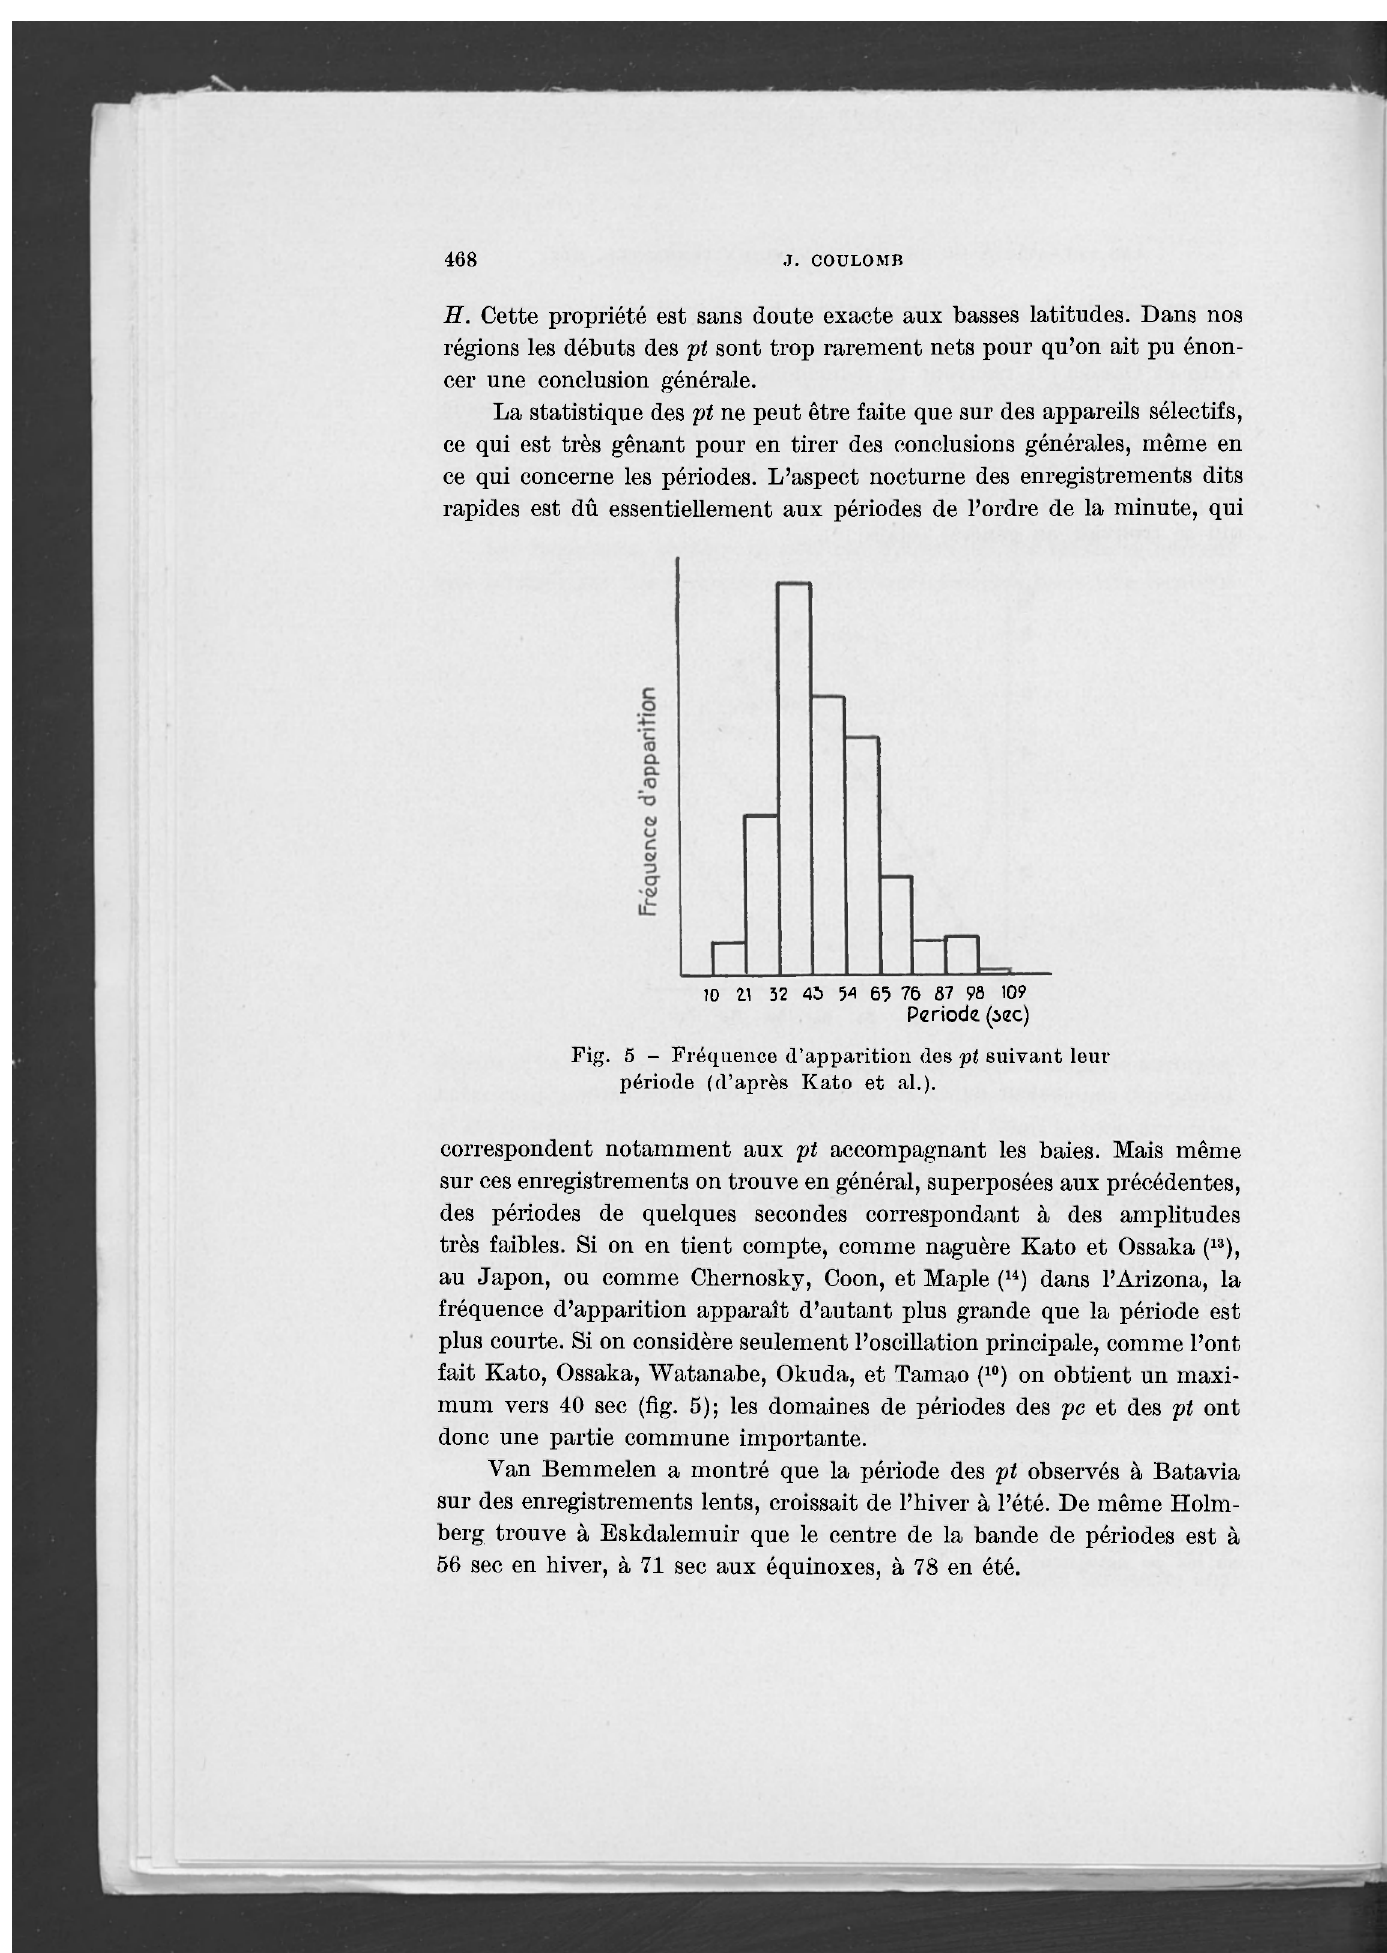
Pig. 5 - Fréquence d'apparition des pt suivant leur période (d'après Kato et al.). correspondent notamment aux pt accompagnant les baies. Mais